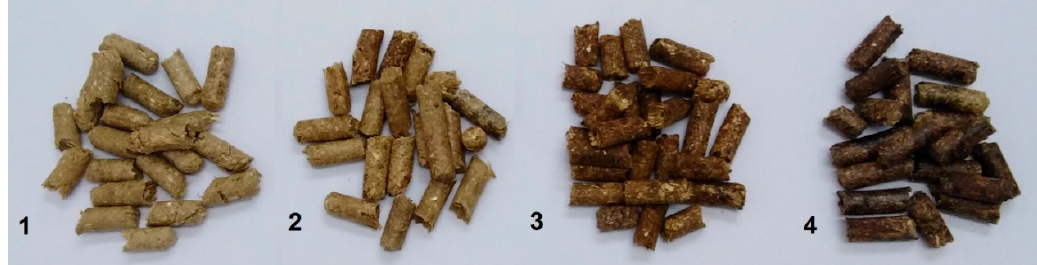
Figure 2. View of pellets: 1 —barley straw 100%, 2 —barley straw with carrot pomace 30%, 3 —barley straw with apple pomace 30%, and 4 —barley straw with red beet pomace 30%.